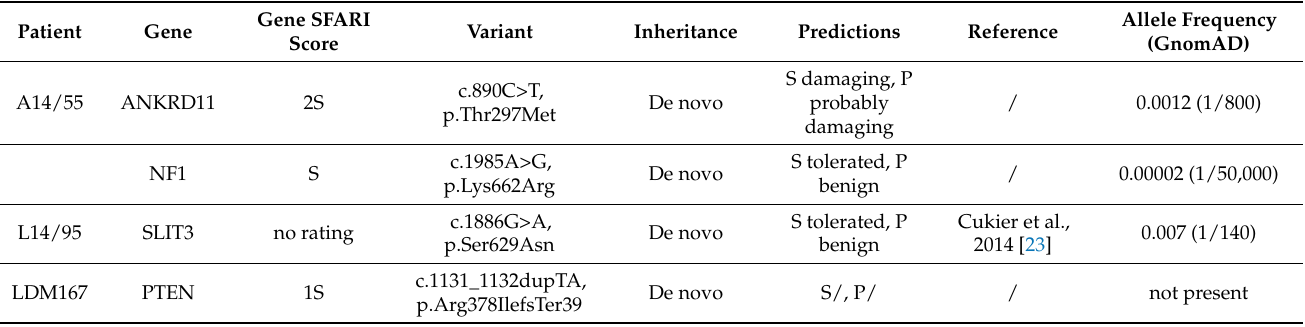
Table 5. De novo variants.